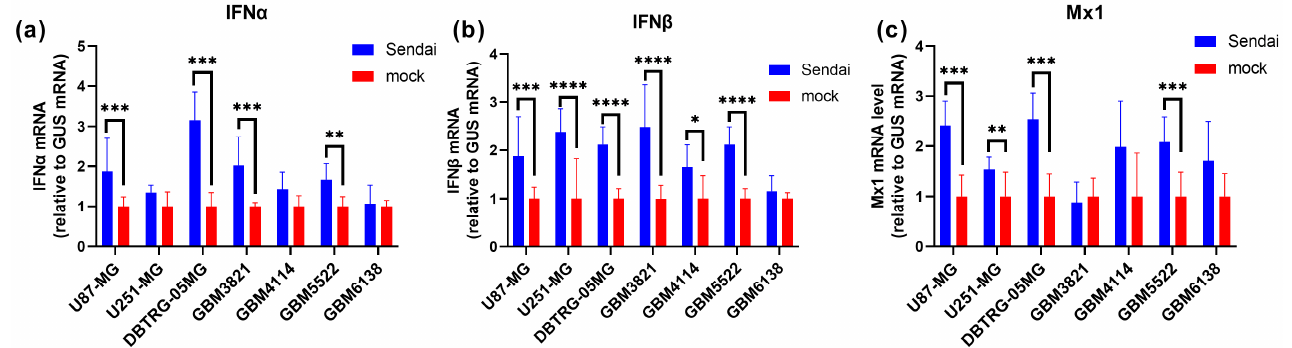
Figure 5. The hyperpermissive GBM6138 cell line has an impaired type I interferon system. Glioblastoma U87-MG, U251-MG, DBTRG-05MG, GBM3821, GBM4114, GBM5522 and GBM6138 were infected with Sendai virus, preinactivated with ultraviolet, and 24 hpi expression of interferons α ( a ) and β ( b ) as well as Mx1 ( c ) gene was assessed by RT-qPCR in cells. The values are the means ± standard deviation (S.D.). * p < 0.05, ** p < 0.01, *** p < 0.001, **** p < 0.0001.